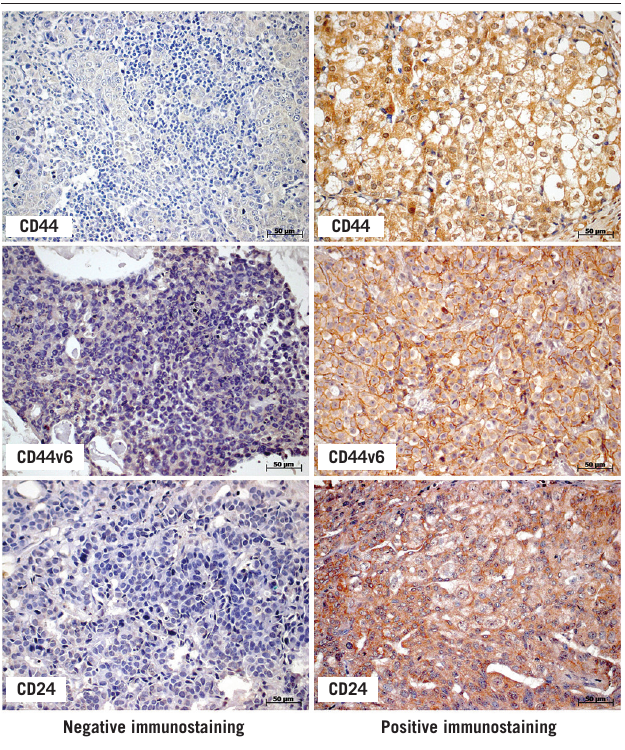
figurE − IHC presentation of negative control (left panel) and positive (right panel) tissue for selected markers (40× magnification) IHC: